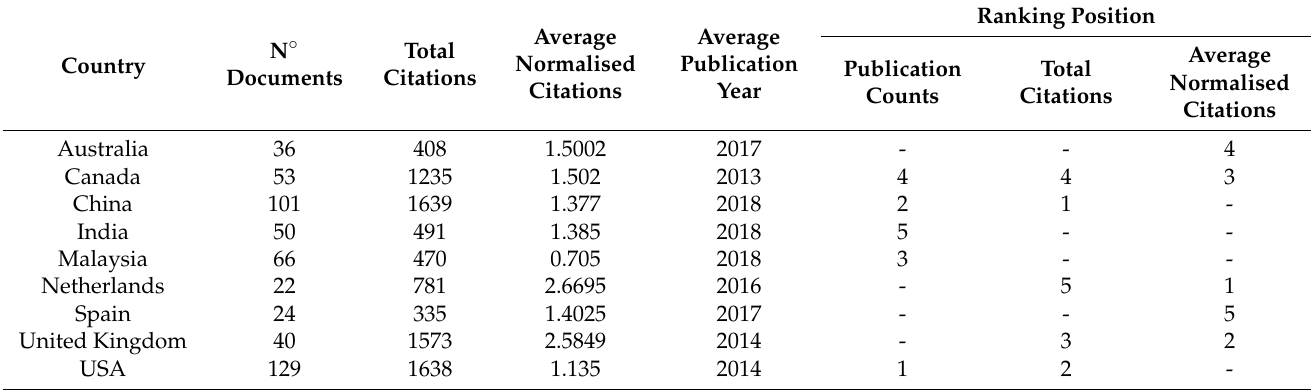
Table 4. Main countries in terms of publication count, total citations, and average normalised citations.